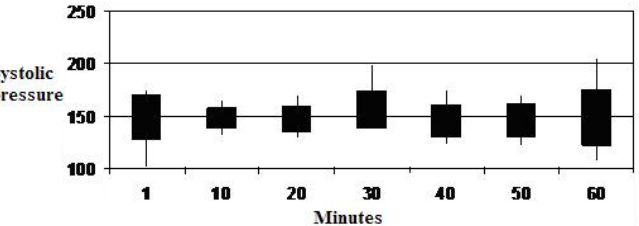
FIGURE 5 - Systolic Pressure during transoperatory